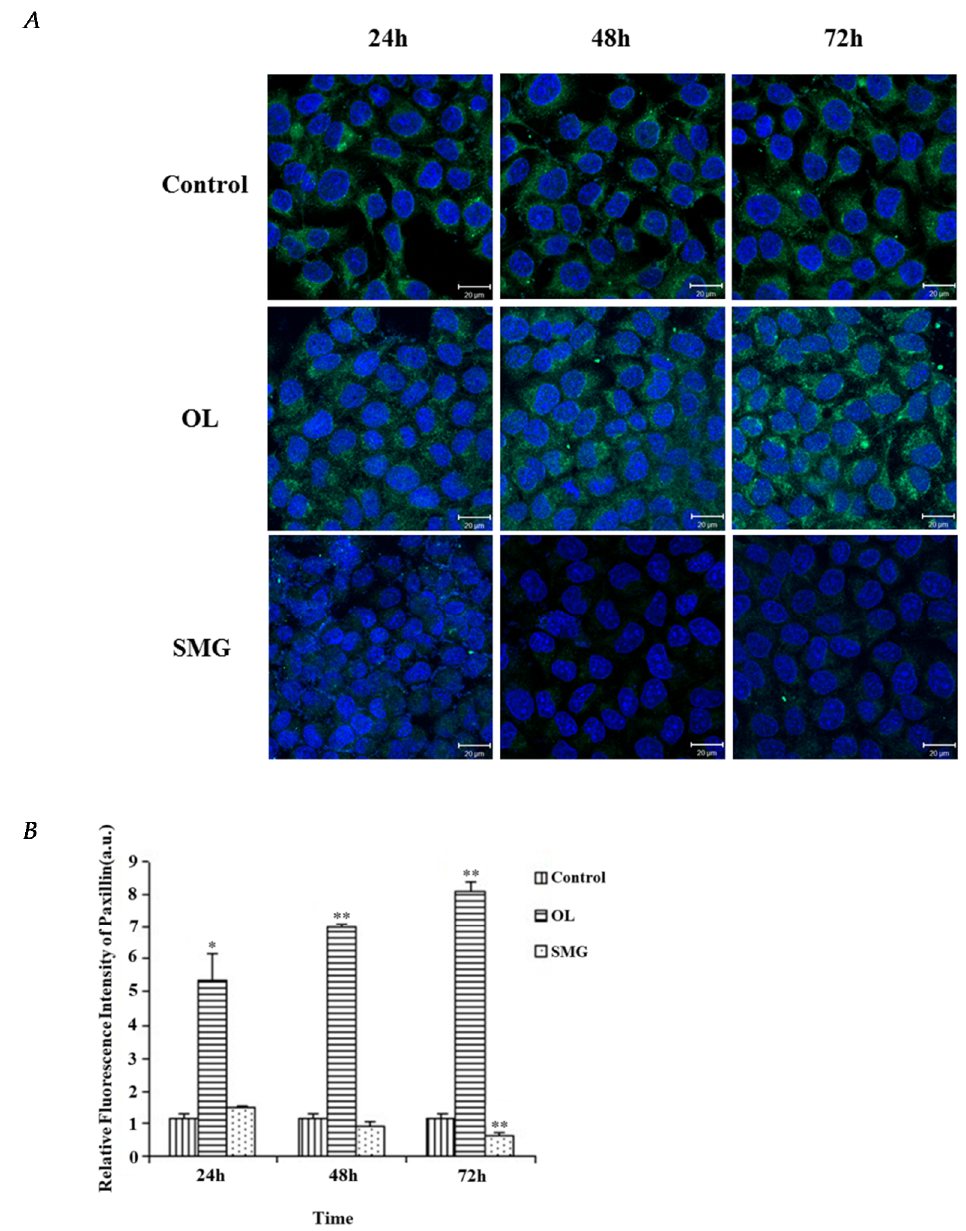
Figure 5. Expression of paxillin in HUVEC cells after cell mechanics treatment. ( A ) The results of immunofluorescence experiments. The blue color indicates the nucleus, and the green color represents the paxillin protein. a. 24 h Control; b. 48 h Control; c. 72 h Control; d. 24 h Overload; e. 48 h Overload; f. 72 h Overload; 24 h SMG; h.48 h SMG; i. 72 h SMG. ( B ) Relative fluorescence intensity of paxillin in HUVEC cells after mechanical changes. * p < 0.05, significant difference; ** p < 0.01, extremely significant.